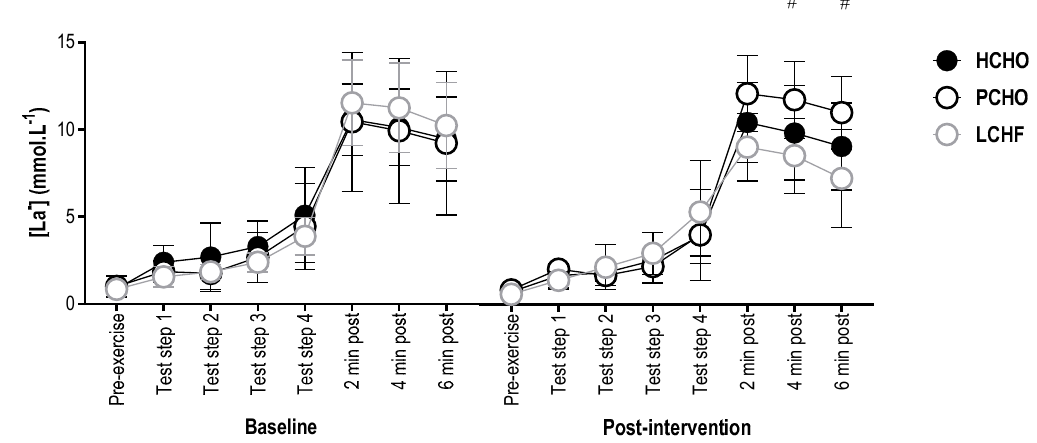
Figure 4. Blood [La − ] for the high carbohydrate (HCHO), periodized carbohydrate (PCHO) and low carbohydrate high fat (LCHF) groups for baseline and post-testing at pre-exercise, steps 1, 2, 3, and 4 of the economy test, and 2, 4, and 6 min post-test. # PCHO significantly different to LCHF ( p <